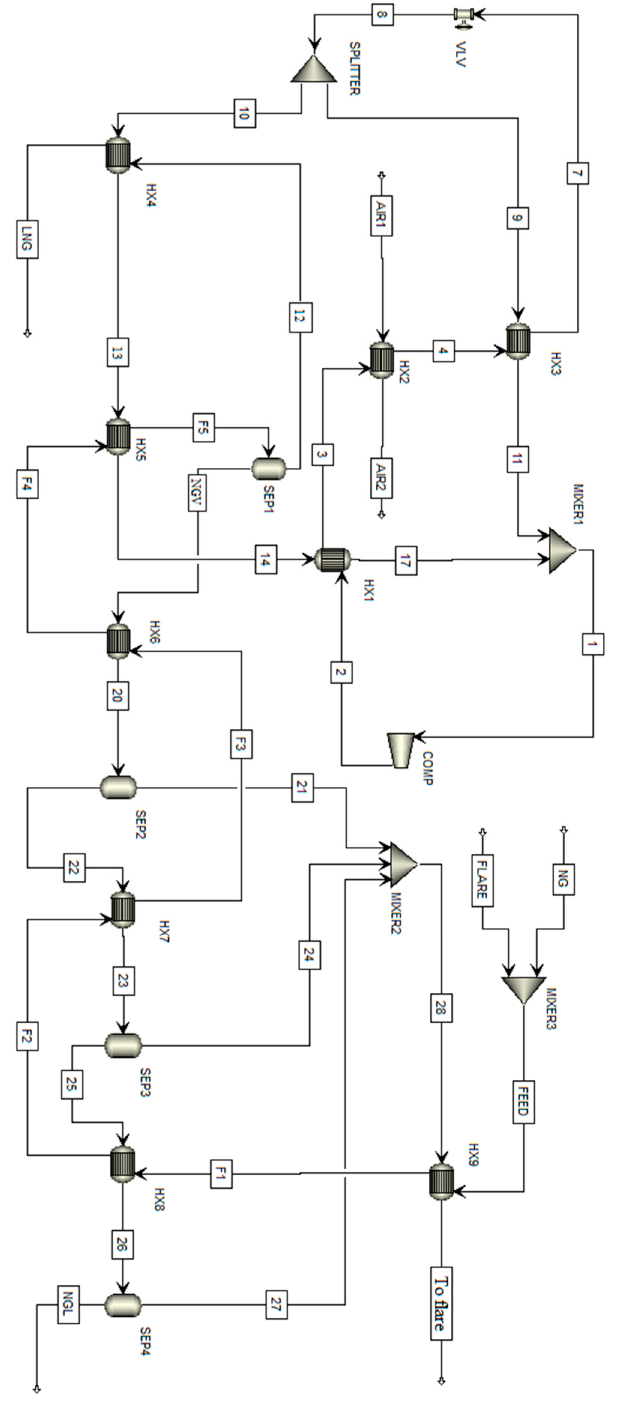
Figure 7. Flare recovery process with the production of LNG and NGL.